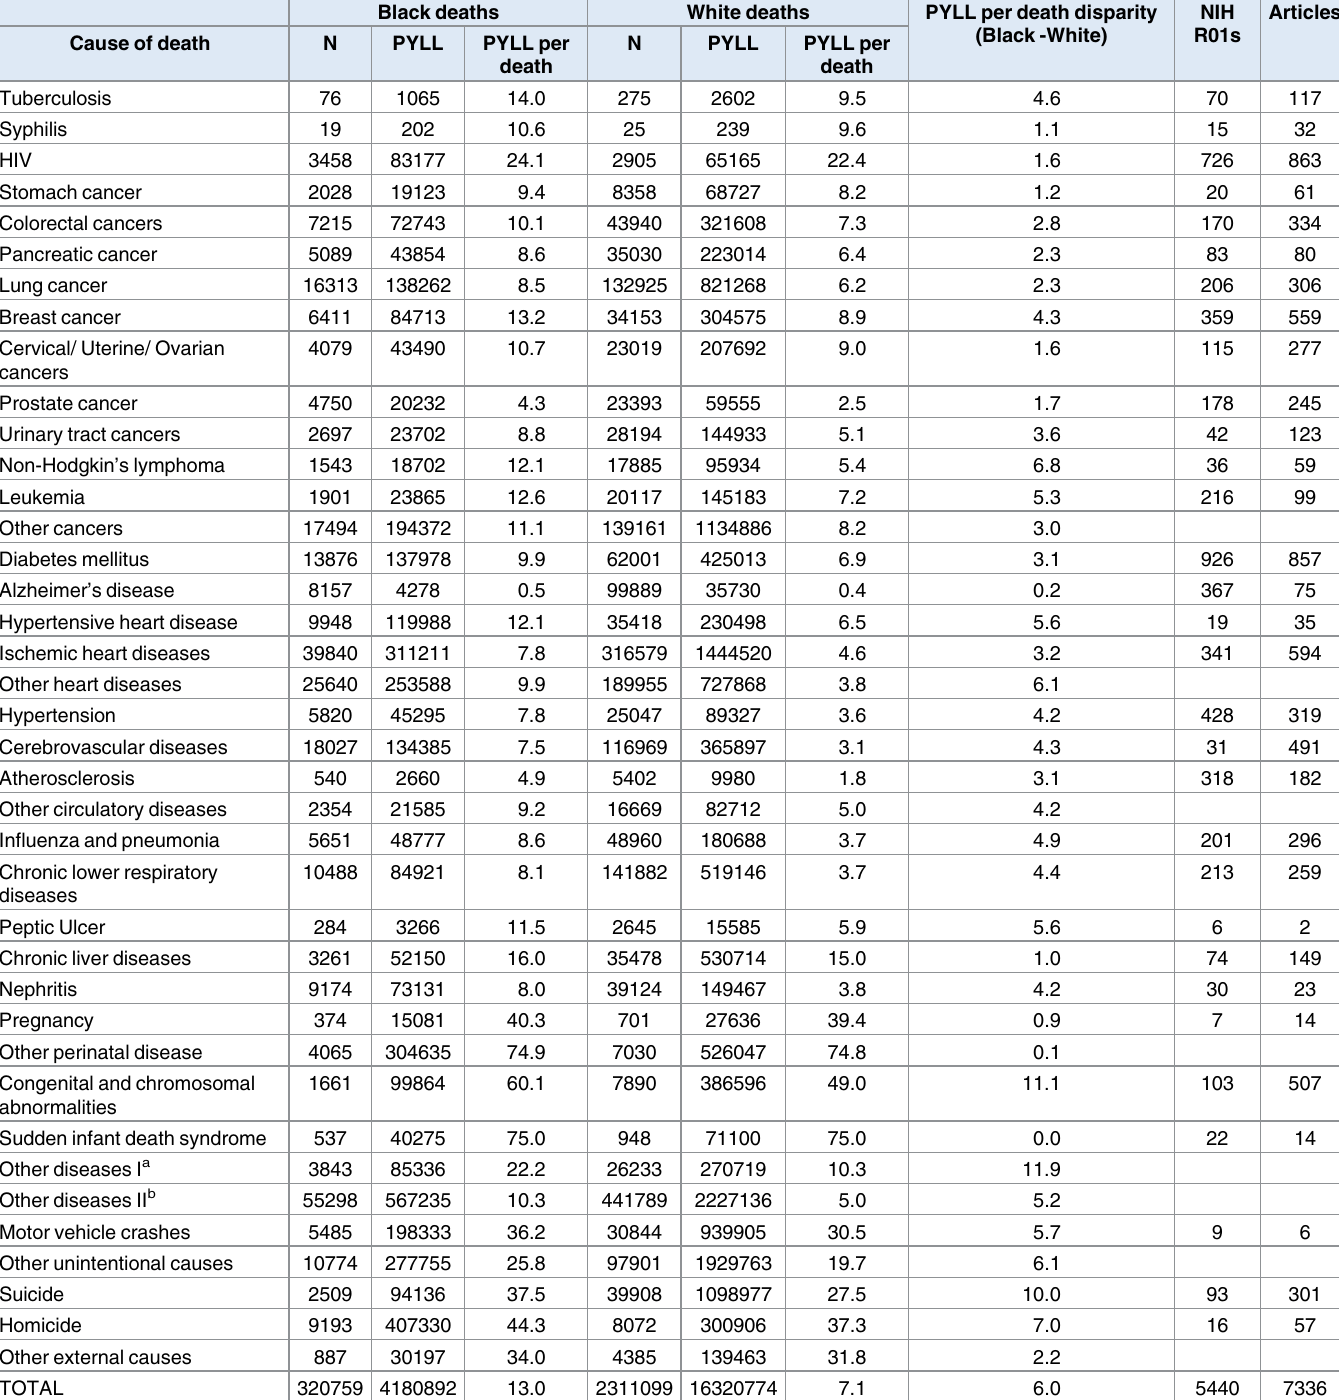
Table 1. Number of deaths and potential yearsof life lost attributed to each of 39 causes of death in all Americans in 2015. Number of NationalInsti- tute of Health R01 grants and scientificarticles published on each specific cause of death (n = 31) in 2015 are also